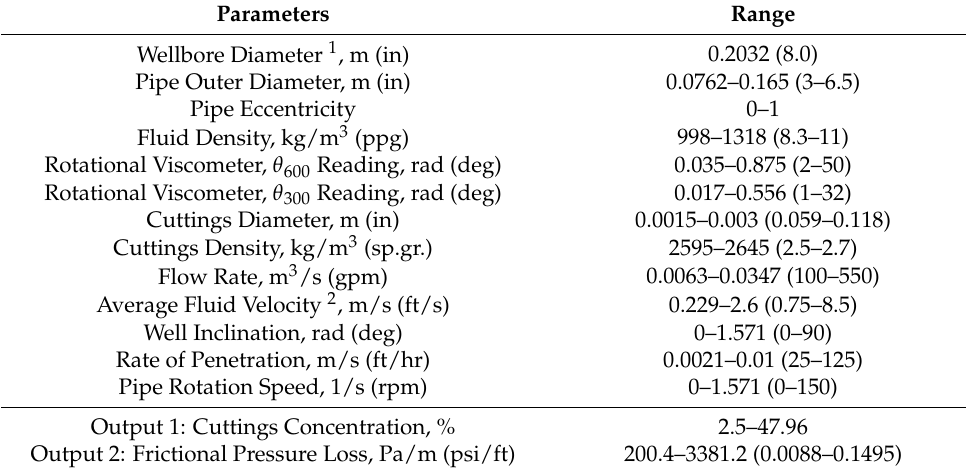
Table 1. A summary of the data used in this